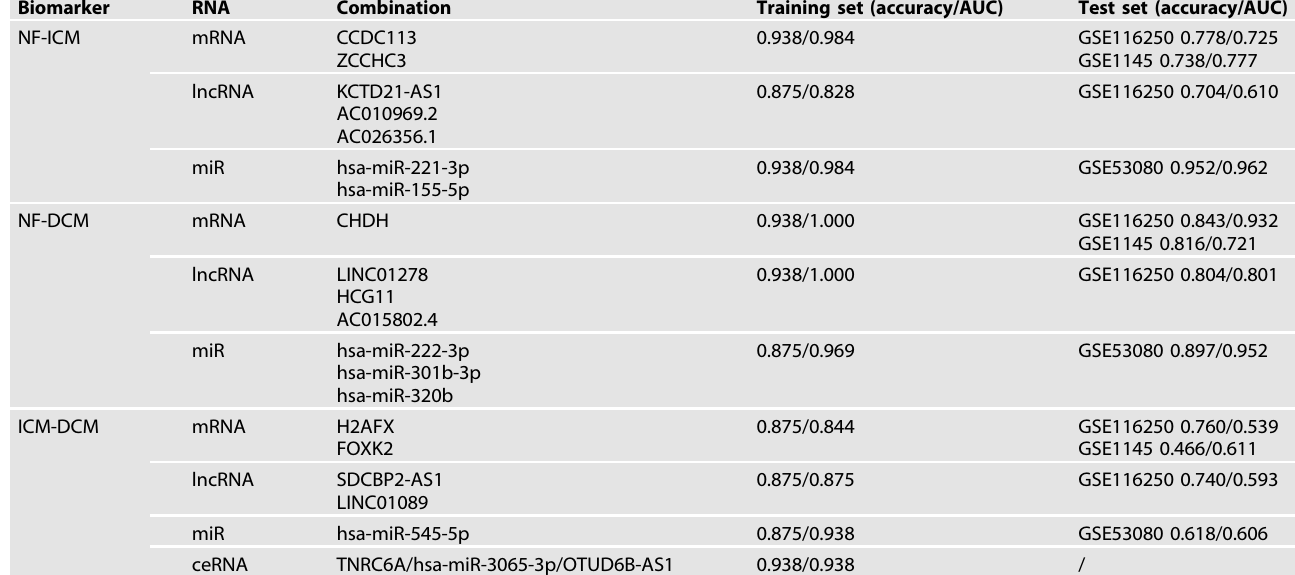
Table 2. Classi fi cation performance of the identi fi ed diagnostic biomarkers associated with ICM and DCM based on LOOCV. Biomarker